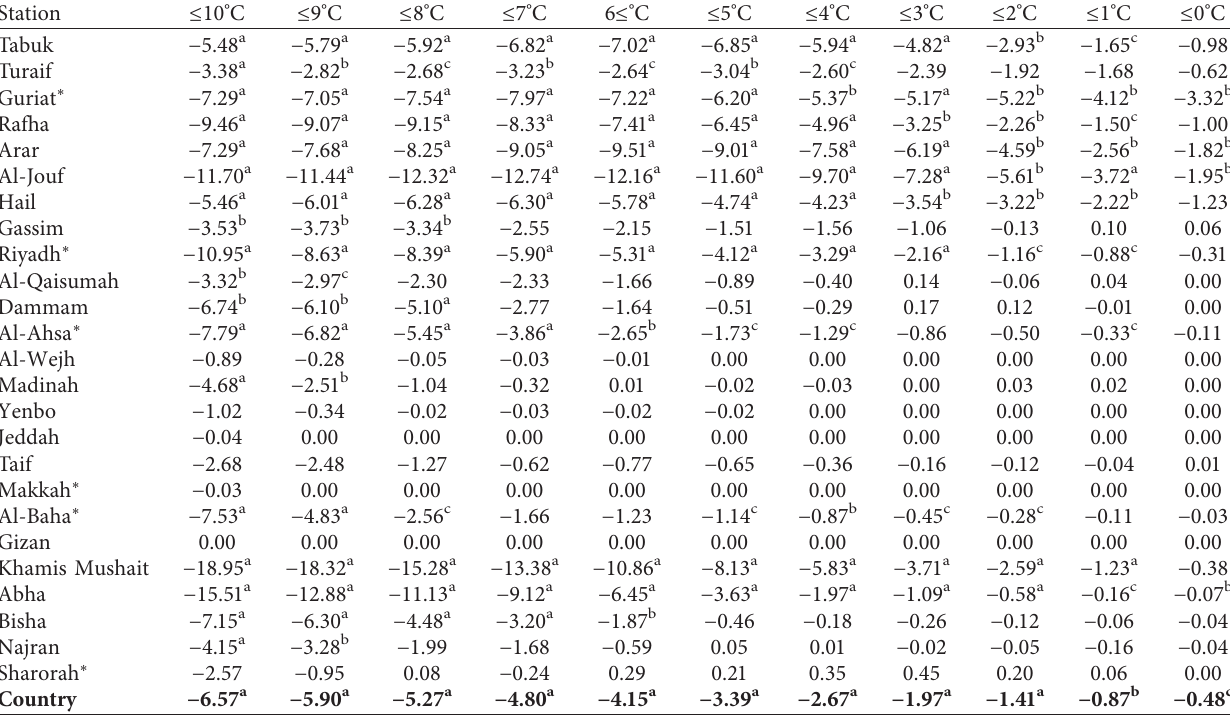
Table 4: Minimum temperature (TN) linear trends ( ° C per decade) of at different absolute thresholds in Saudi Arabia for the period 1978–2019.